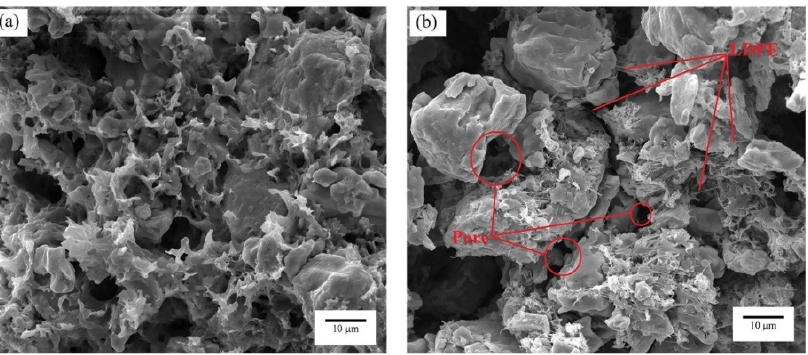
Figure 9. SEM image of samples: ( a ) injected part; ( b ) solvent debound part. Reproduced with permission from reference [74] copyright © 2020 Elsevier B.V.